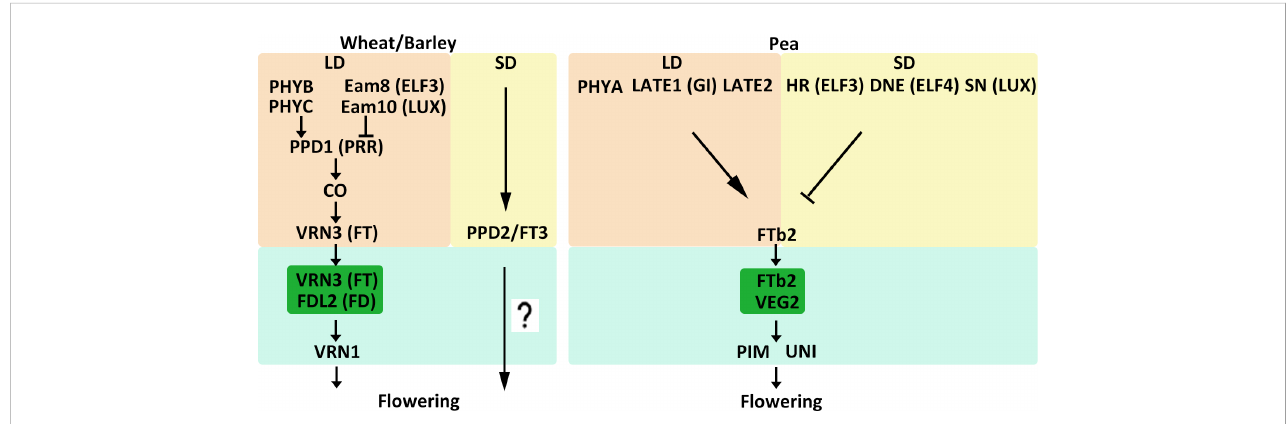
FIGURE 2 Model of fl owering time control pathways in major LD crops. The different external and internal cues are highlighted in different colors. Positive and negative regulatory actions are indicated by arrows and lines with bares,